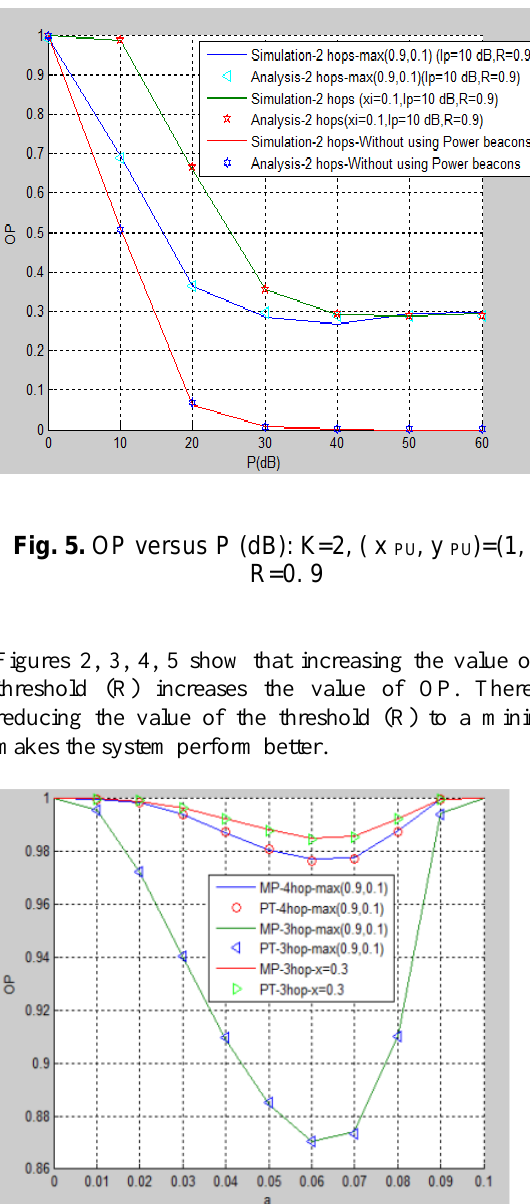
Fig. 4. OP versus P (dB) : K=2, (x PU , y PU )=(2, 2), R=0. 9